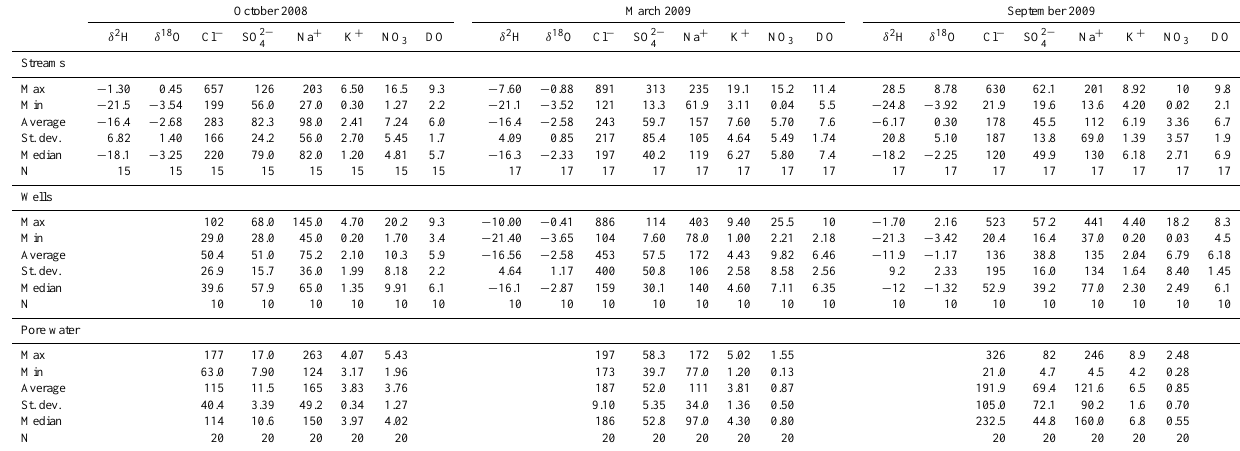
Table 1. Measured values and descriptive statistics of chemical variables in the stream water, shallow groundwater and pore water samples during the studied period (October 2008, March 2009 and September